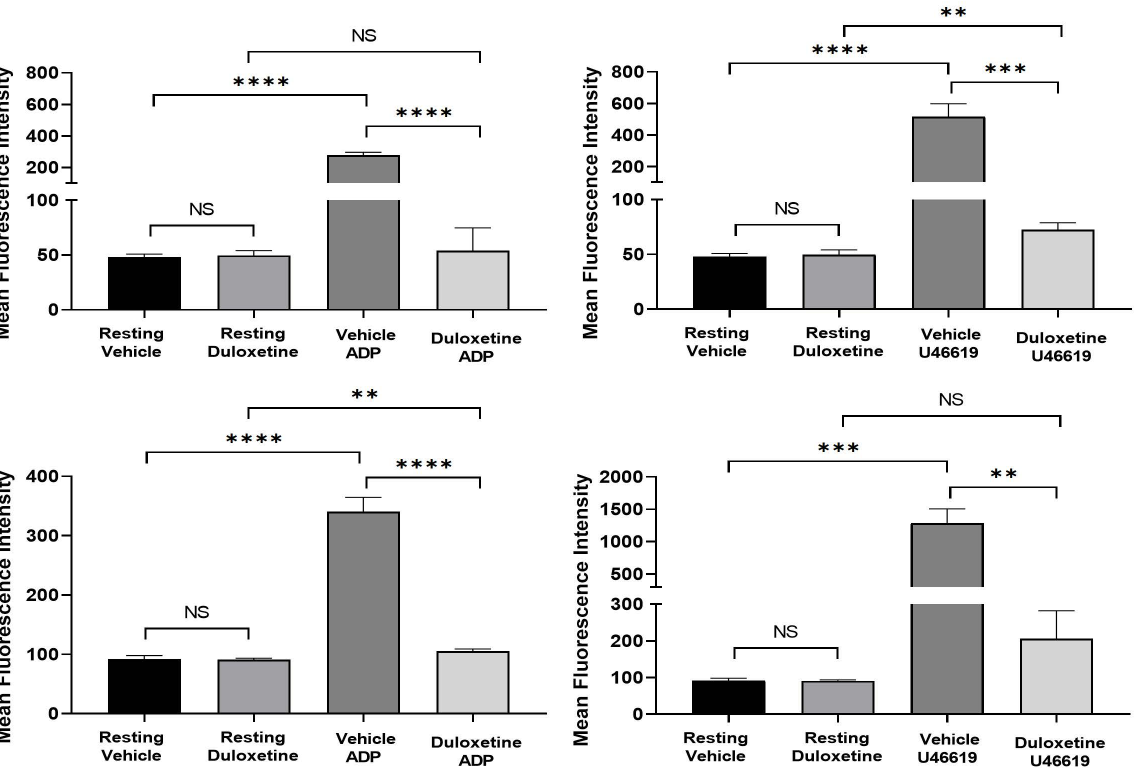
Figure 4. Duloxetine inhibits glycoprotein IIb-IIIa activation ( A , B ) and phosphatidylserine expres- sion ( C , D ). Washed human platelets were pre-incubated with duloxetine (35 µ M) or the vehicle for one minute. Platelets were incubated with FITC-conjugated PAC-1 antibody ( A , B ) and Annexin V antibody ( C , D ) before stimulation with ADP (1 µ M; ( A , C )) or U46619 (5 µ M; ( B , D )). Fluorescent in- tensities were measured by flow cytometry. Average mean fluorescence intensities shown (** p < 0.01; *** p < 0.001; **** p < 0.0001; NS, nonsignificant). These experiments were repeated three times, using blood obtained from three different healthy human subjects. The results were compared by running a one-way ANOVA followed by Tukey’s multiple comparisons test using GraphPad